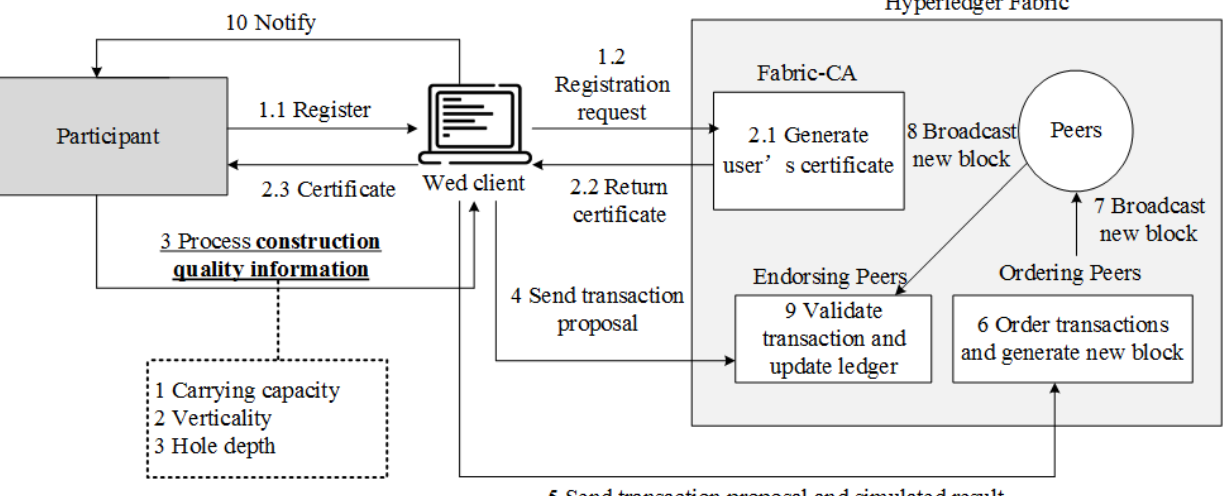
Figure 47. Reconstruction diagram of reference [81].